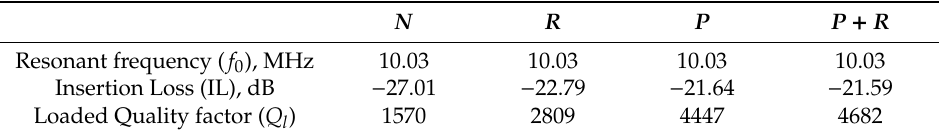
Figure 11. The narrow band S21 curve of the resonator. ( a ) Conventional structure; ( b ) With acoustic reflector on the anchoring boundaries; ( c ) With 1D-PnC on the tether; ( d ) With 1D-PnC and acoustic reflector composite structure. Table 3. Average values of the measured electrical characteristics of the fabricated resonators.